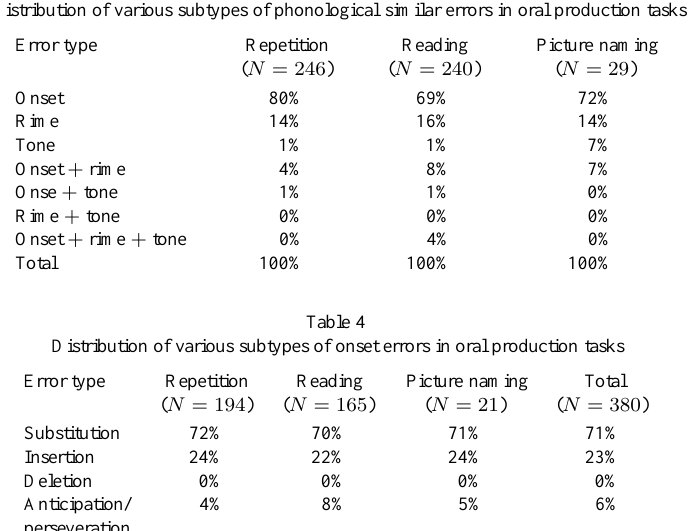
Table 3 Distribution of various subtypes of phonological similar errors in oral production tasks